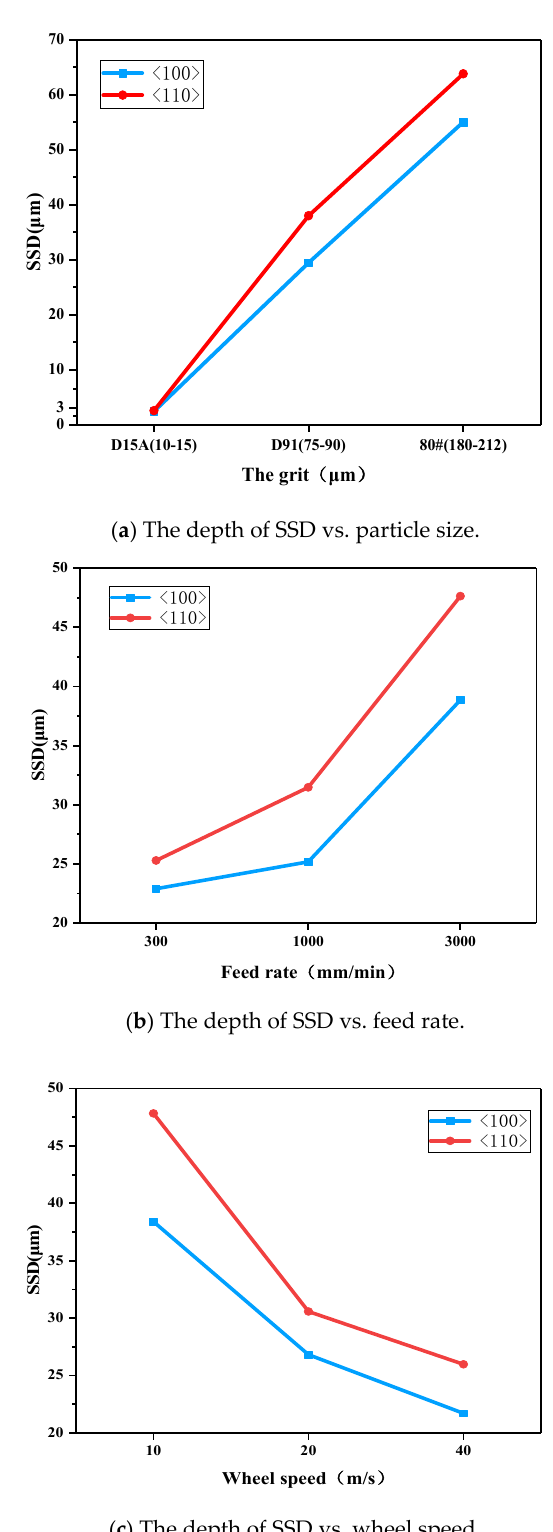
Figure 11. Sub-surface damage (SSD) vs. grinding parameters by range analysis: error bars represent standard deviations.